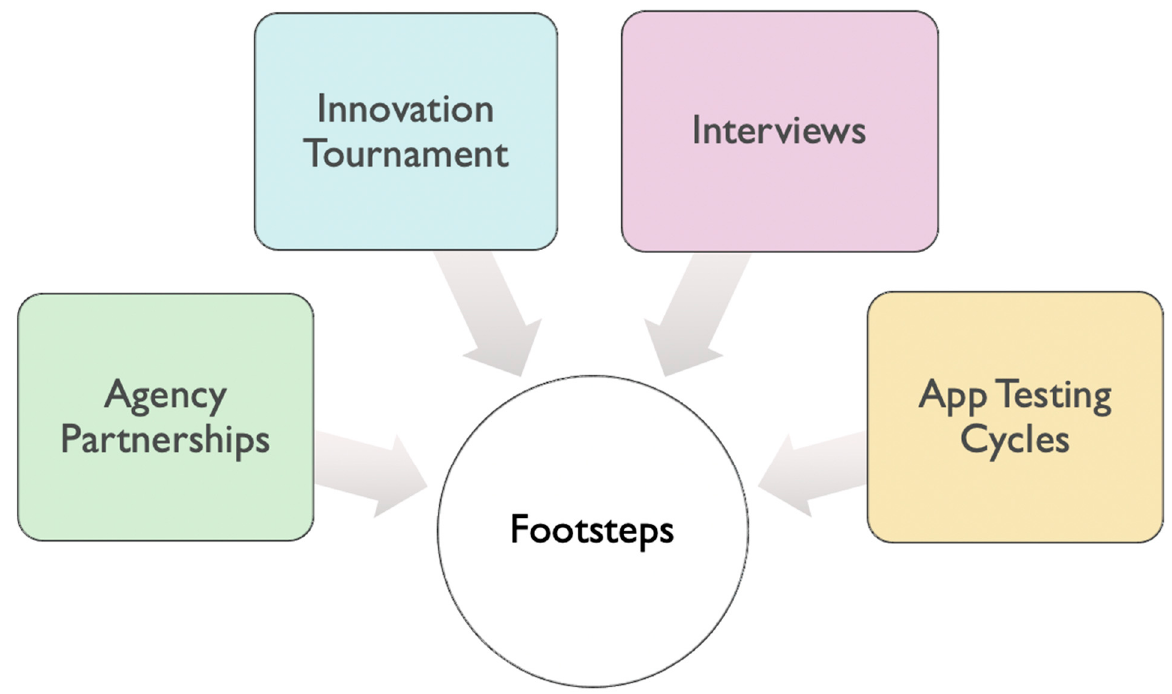
Figure 1. App development